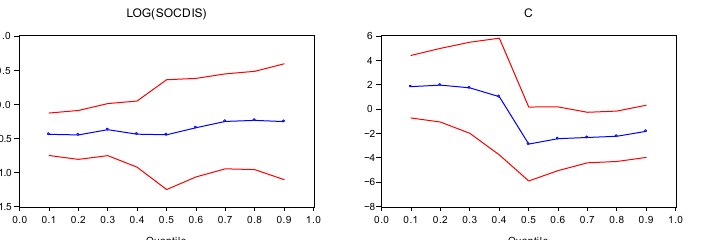
Figure 2. Quantile Process Estimates. Source: Authors’ estimates. Note: SVAD shows services value-added, COMD shows communicable disease, WOM shows word-of-mouth, LOCKDOWN shows lockdown, FACT shows financial activity, EACT shows economic activity, PCONT shows price control, and SOCIDIS shows social distancing. LOG shows natural logarithm. C shows constant. Red lines shows the critical region.Blue line shows the estimated value.